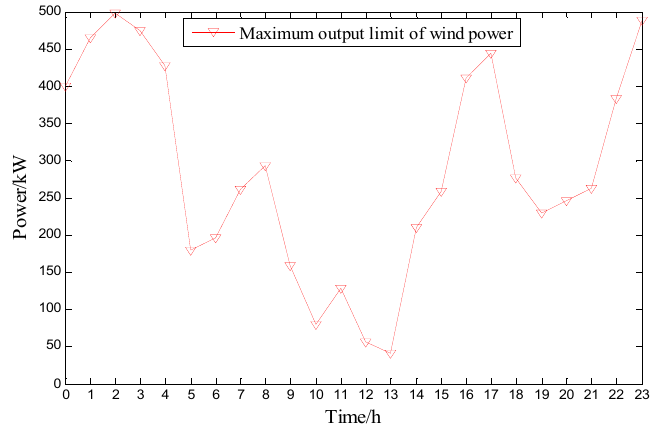
Figure 8. Maximum output prediction curve of wind power generation without restriction.